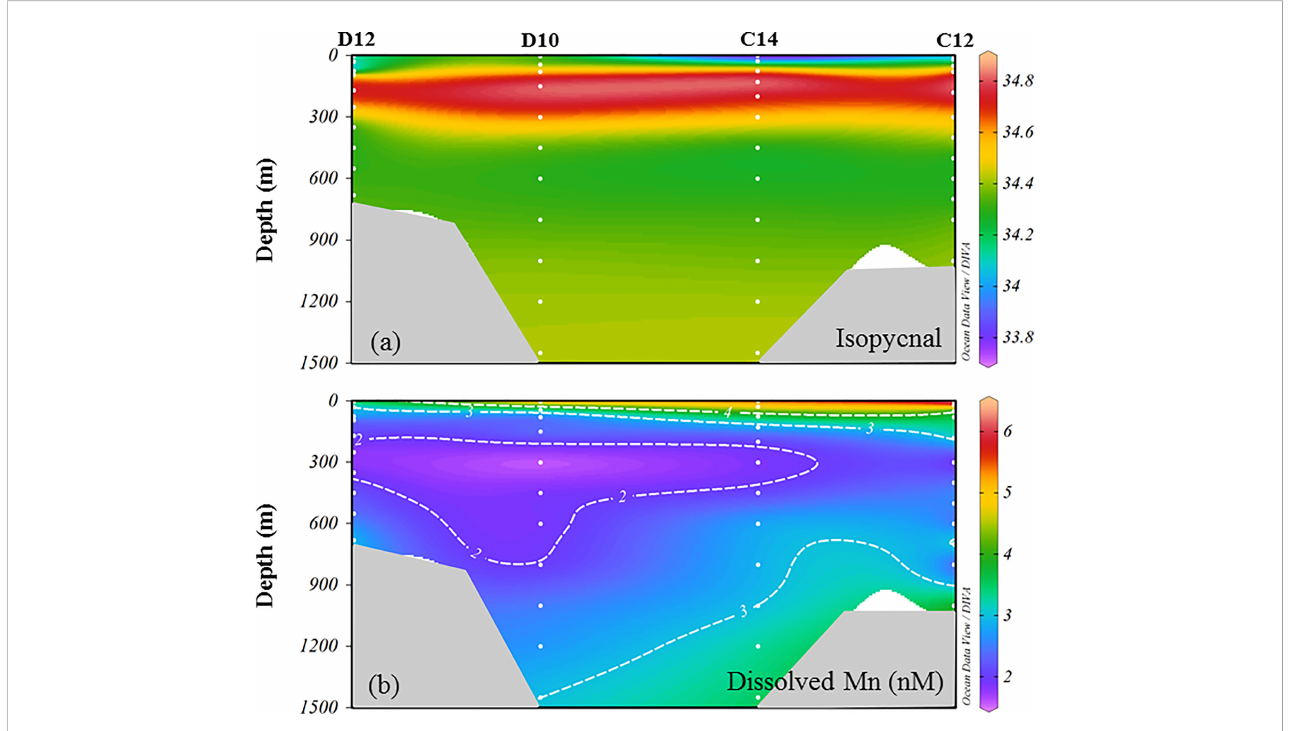
FIGURE 6 Vertical distributions of salinity (A) and dissolved Mn (B) across the KW